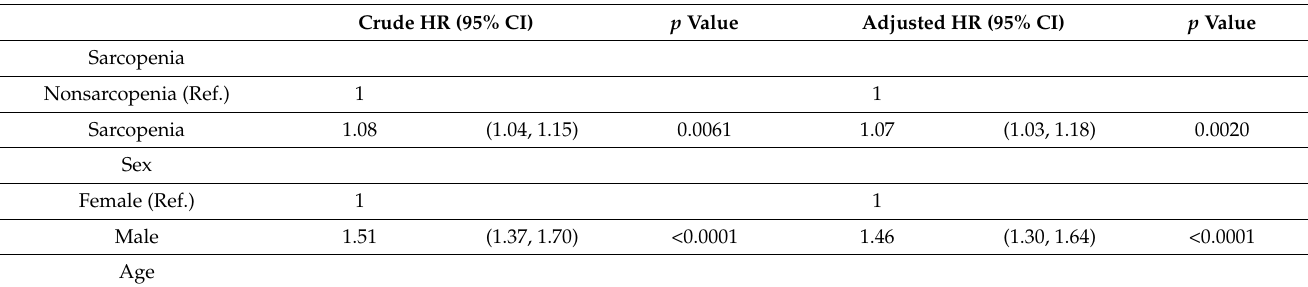
Table 3. Univariable and multivariable Cox proportional regression model for locoregional recurrence of the propensity score-matched groups of patients with oral cavity squamous cell carcinoma with and without pre-existing